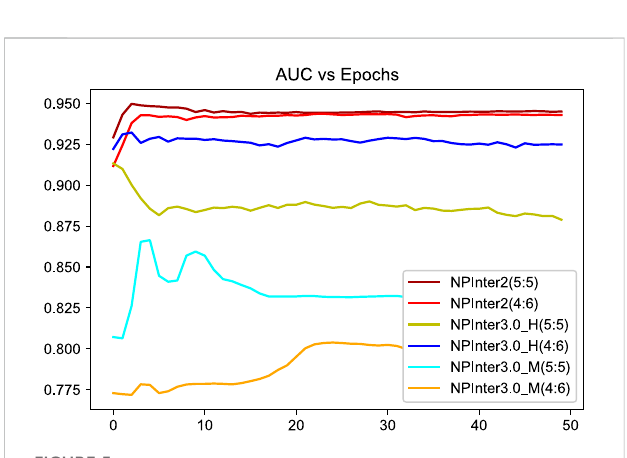
FIGURE 5 Algorithm convergence of the model under different data sets.